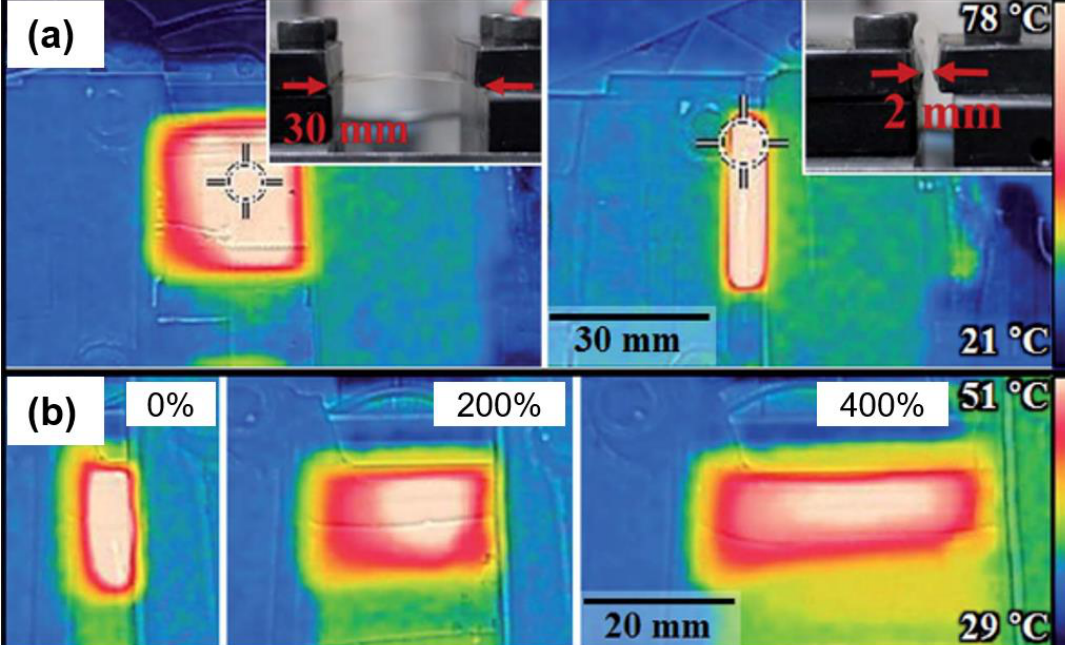
Figure 23. ( a ) Photographs and infrared (IR) images of Ag NW films during bending tests. ( b ) Photographs and IR images of Ag NW films during the stretching in the initial (0%), intermediate (200%), and final (400%) states. Reproduced with permission from [106]. Copyright 2017 Royal Society of Chemistry.